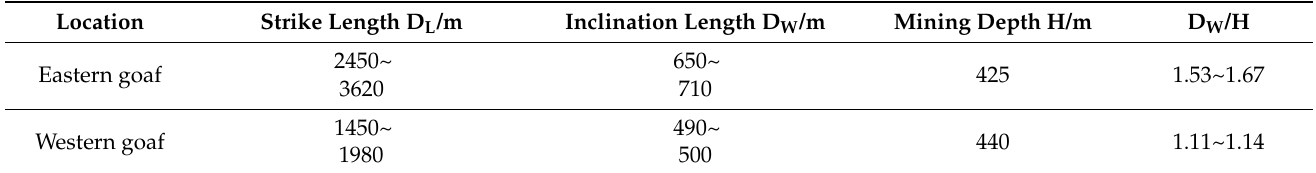
Table 2. Judgment table for goaf mining adoption level.